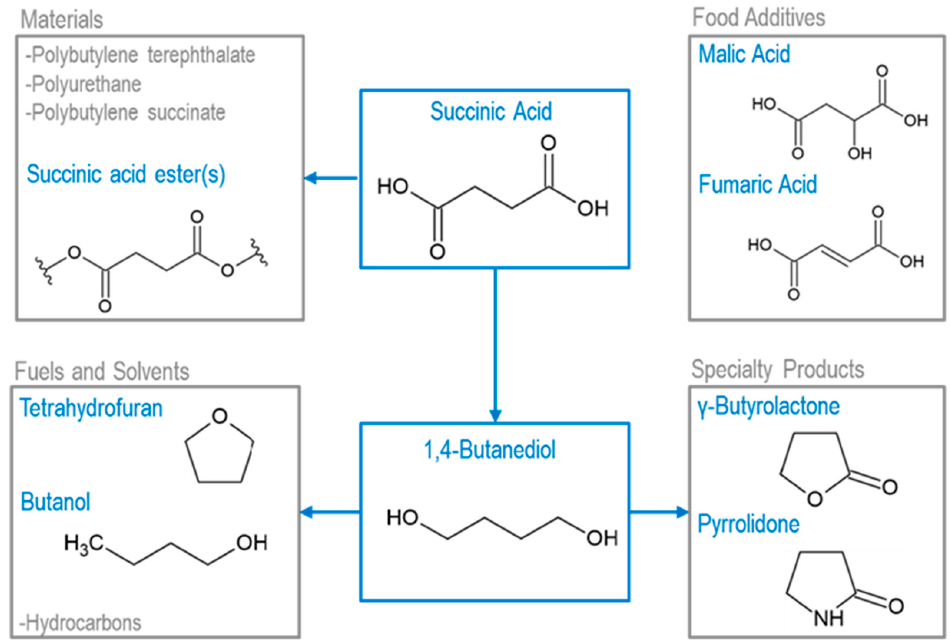
Figure 6. Schematic of potential upgrading possibilities for conversion of succinic acid (with malic and fumaric acids highlighted as a food additive) to high-value products.